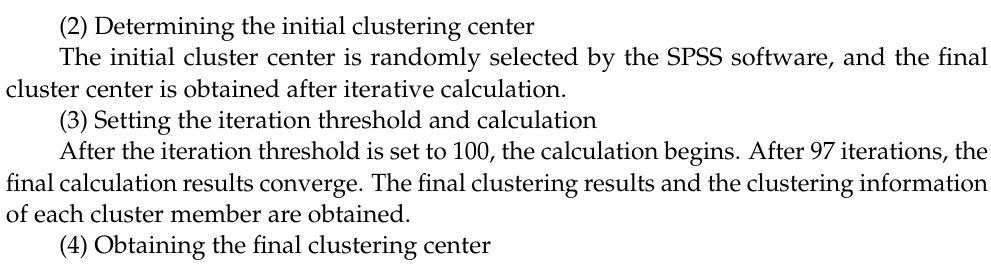
Figure 3. Diagram of the elbow rule for determining K-means. The y-axis is the SSE and the x-axis is the value of k. As x increases, the SSE decreases, and when the decrease tends to be significantly slower, the value is considered to be the best value of k.